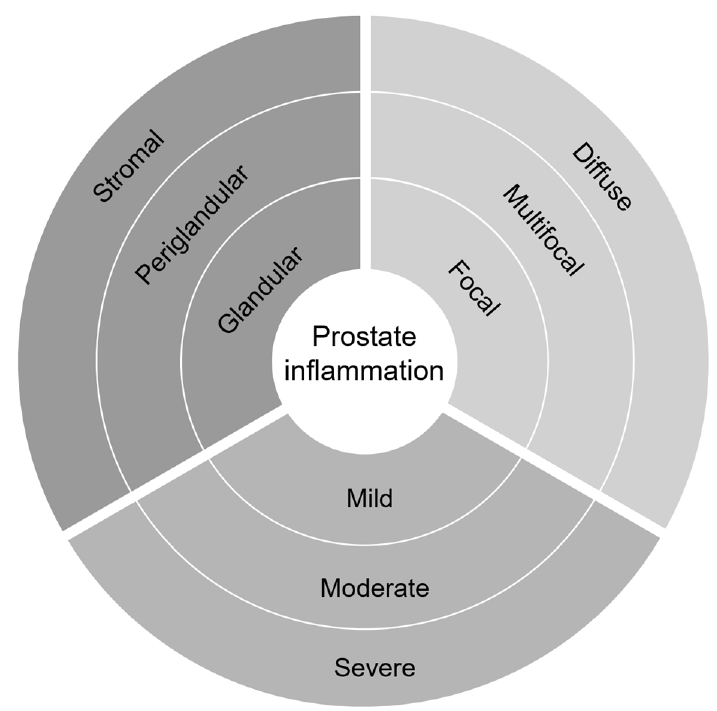
Figure 1. The histological classification of prostatic inflammatory infiltrates. Prostate inflammation is classified according to the inflammation extent (focal, <10%; multifocal, 10–50%; or diffuse, >50%) and grade (mild, <100 cells/mm 2 ; moderate, 100–500 cells/mm 2 ; or severe, >500 cells/mm 2 ) in each tissue location (glandular, periglandular, and stromal). (Adapted from Nickel et al. [43]). Studies assessing histological inflammation using H&E-stained tissues have reported contrasting associations with prostate cancer risk. Two studies by Platz et al. within the PCPT indicated that benign tissue inflammation was positively associated with the presence of prostate cancer, especially high-grade [4,5]. In their results, men with inflammation in benign regions of prostate biopsy tissue showed 1.78-times higher odds of being positive for prostate cancer, compared with cases without inflammation. The association was